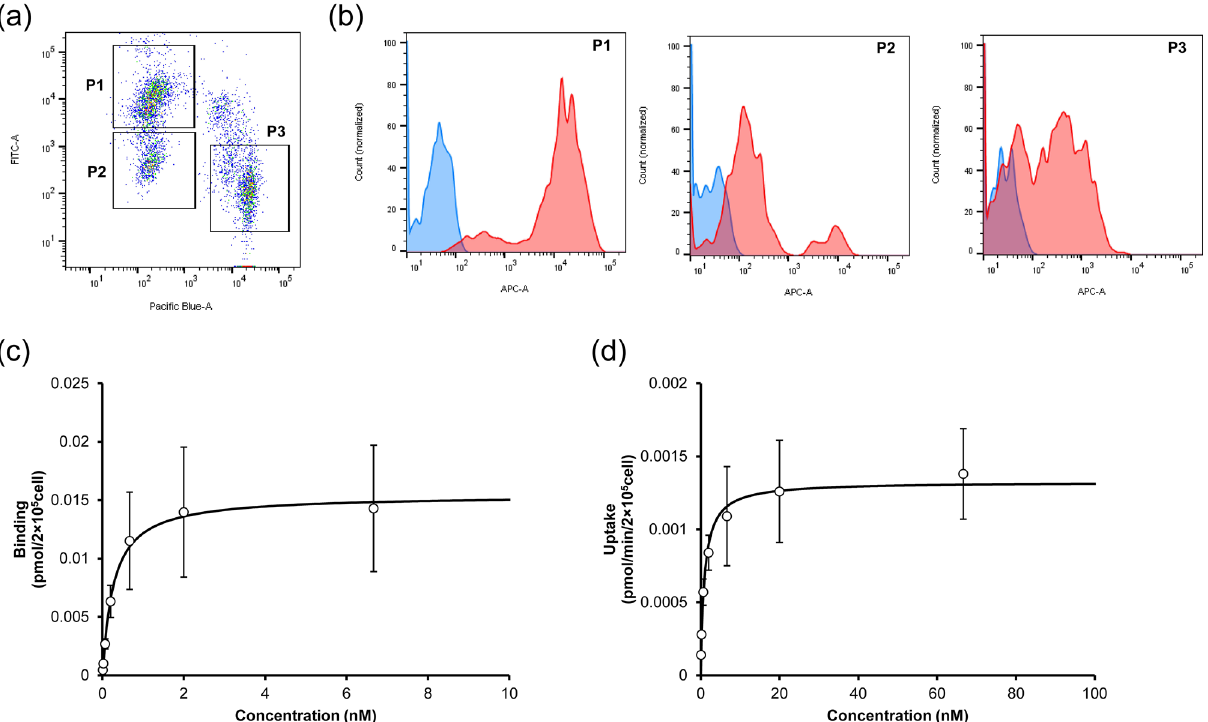
Figure 4. Cellular binding and internalization assay using mouse NPC. ( a ) Cellular dot plot after staining with CD146 and CD45. X axis (Pacific Blue) and Y axis (FITC) shows CD45 and CD146, respectively. CD146 high/CD45 low, CD146 low/CD45 low, and CD146 low/CD45 high population were named as P1, P2, and P3, respectively. ( b ) Histogram of the FcγRIIB expression in each population. X axis (APC) shows the fluorescence of Alexa Fluor 647. Red shows staining with anti- FcγRIIB antibody and blue shows unstaining. ( c ) Concentration-dependent binding of the antibody in P2. The antibody was incubated at 4 °C for 60 min, and fluorescence was detected by FCM. The data were fitted with the receptor-ligand binding equation. ( d ) Concentration-dependent internalization rate of the antibody in P2. The antibody was incubated at 37 °C for 5 min. The data were fitted with the Michaelis–Menten equation. Each point shows the mean ± SD (n = 3).